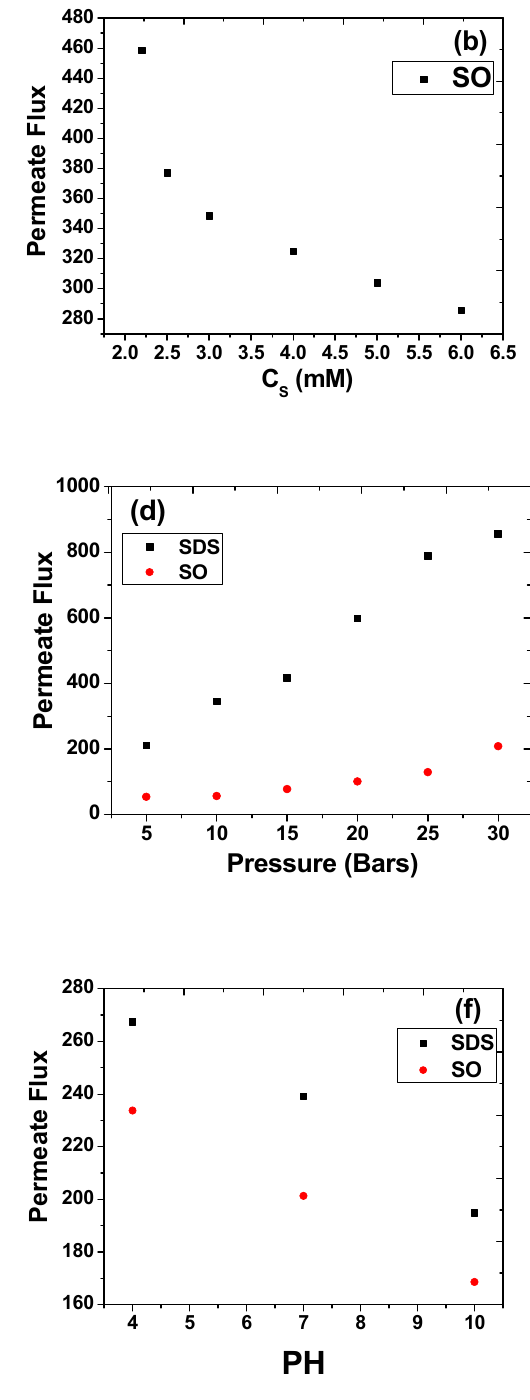
Figure 5. Permeate flux (J) of ( a ) SDS concentration (C SDS ) ( b ) SO concentration (C SO ) ( c ) electrolyte concentration (NaCl) of SDS and SO ( d ) pressure ( e ) RPM ( f ) pH. Concentration of Electrolyte